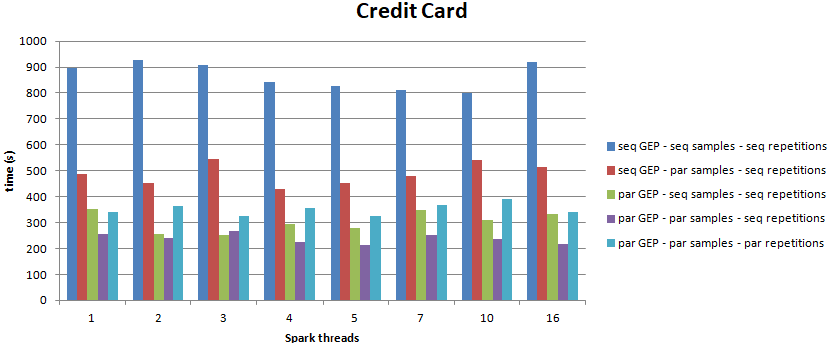
Fig. 3. Time (in s) of 10 repetitions of cross-validation classi¯cation for Credit Card dataset.